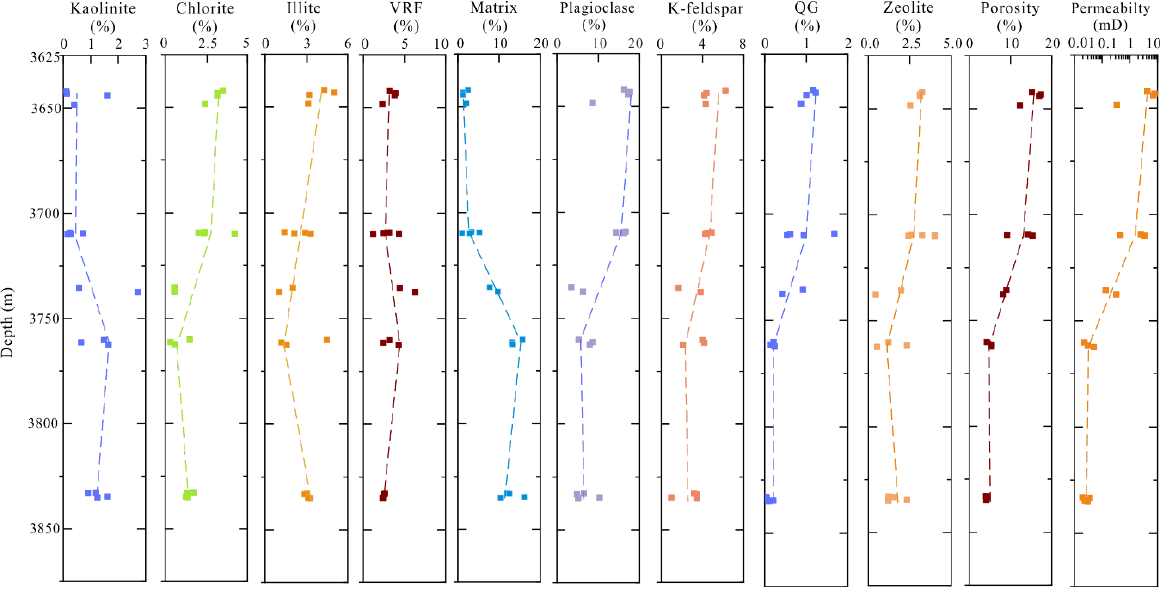
Figure 5. The vertical distribution of mineral composition and petrophysical property in the Toutunhe Formation sandstone. VRF: volcanic rock fragment; QG: quartz overgrowth.